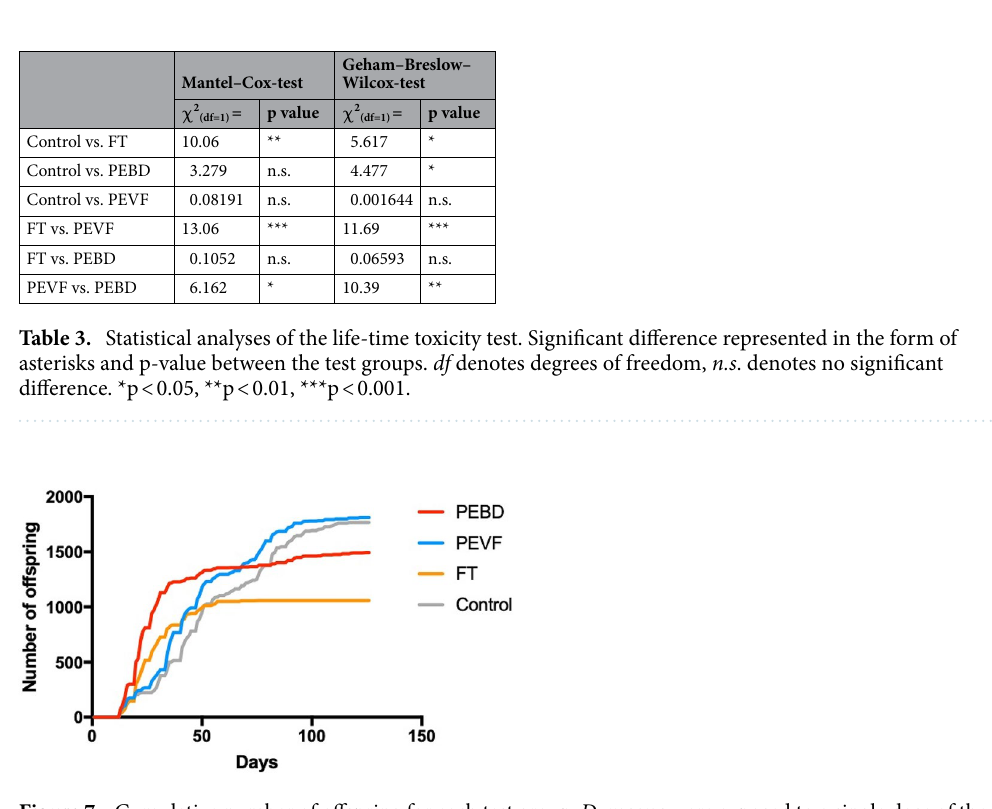
Figure 7. Cumulative number of offspring for each test group. D. magna were exposed to a single dose of the different breakdown fractions. The PEVF contains, in addition to nano-sized plastics, approximately 20%